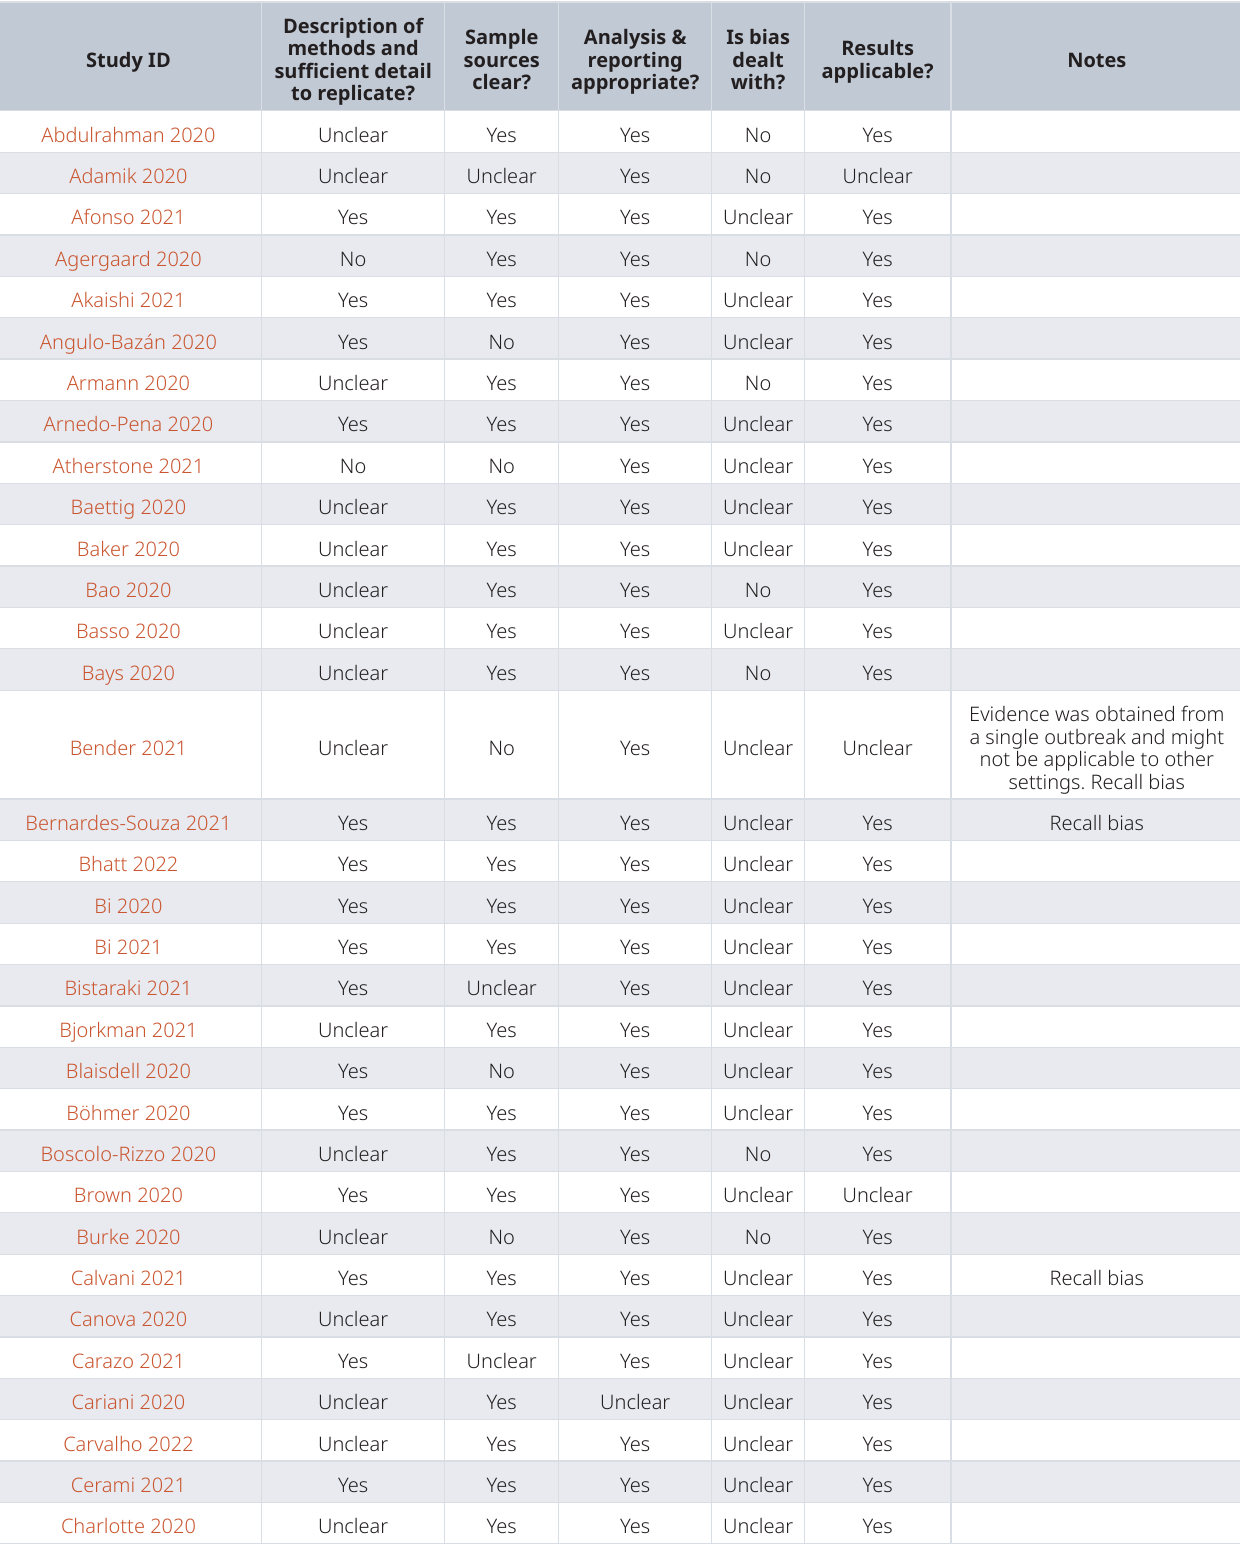
Table 3. Risk of Bias.